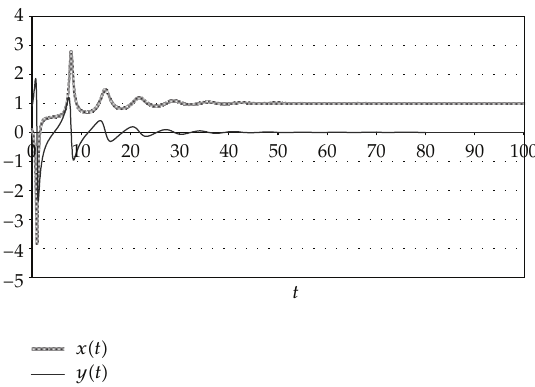
Figure 3: x (cid:2) 0 (cid:3) (cid:6) 0.1, y (cid:2) 0 (cid:3) (cid:6) 0.9, a (cid:6) 0.1, b (cid:6) 0.9, alpha (cid:6)